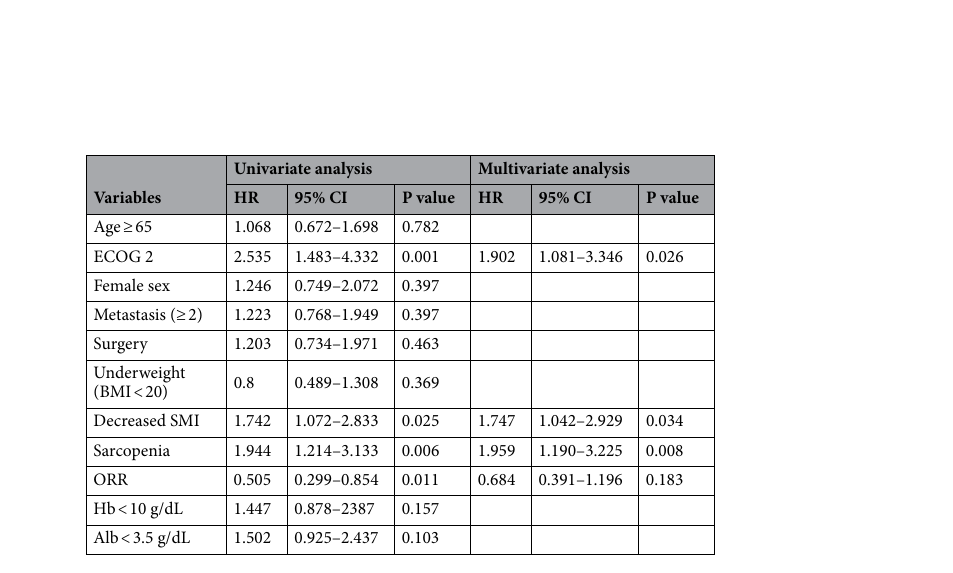
Table 3. Univariate and multivariate analysis of overall survival. CI confidence interval, HR hazard ratio, SMI skeletal muscle index, ECOG Eastern Cooperative Oncology Group, ORR overall response rate, BMI body mass index, Hb hemoglobin, Alb